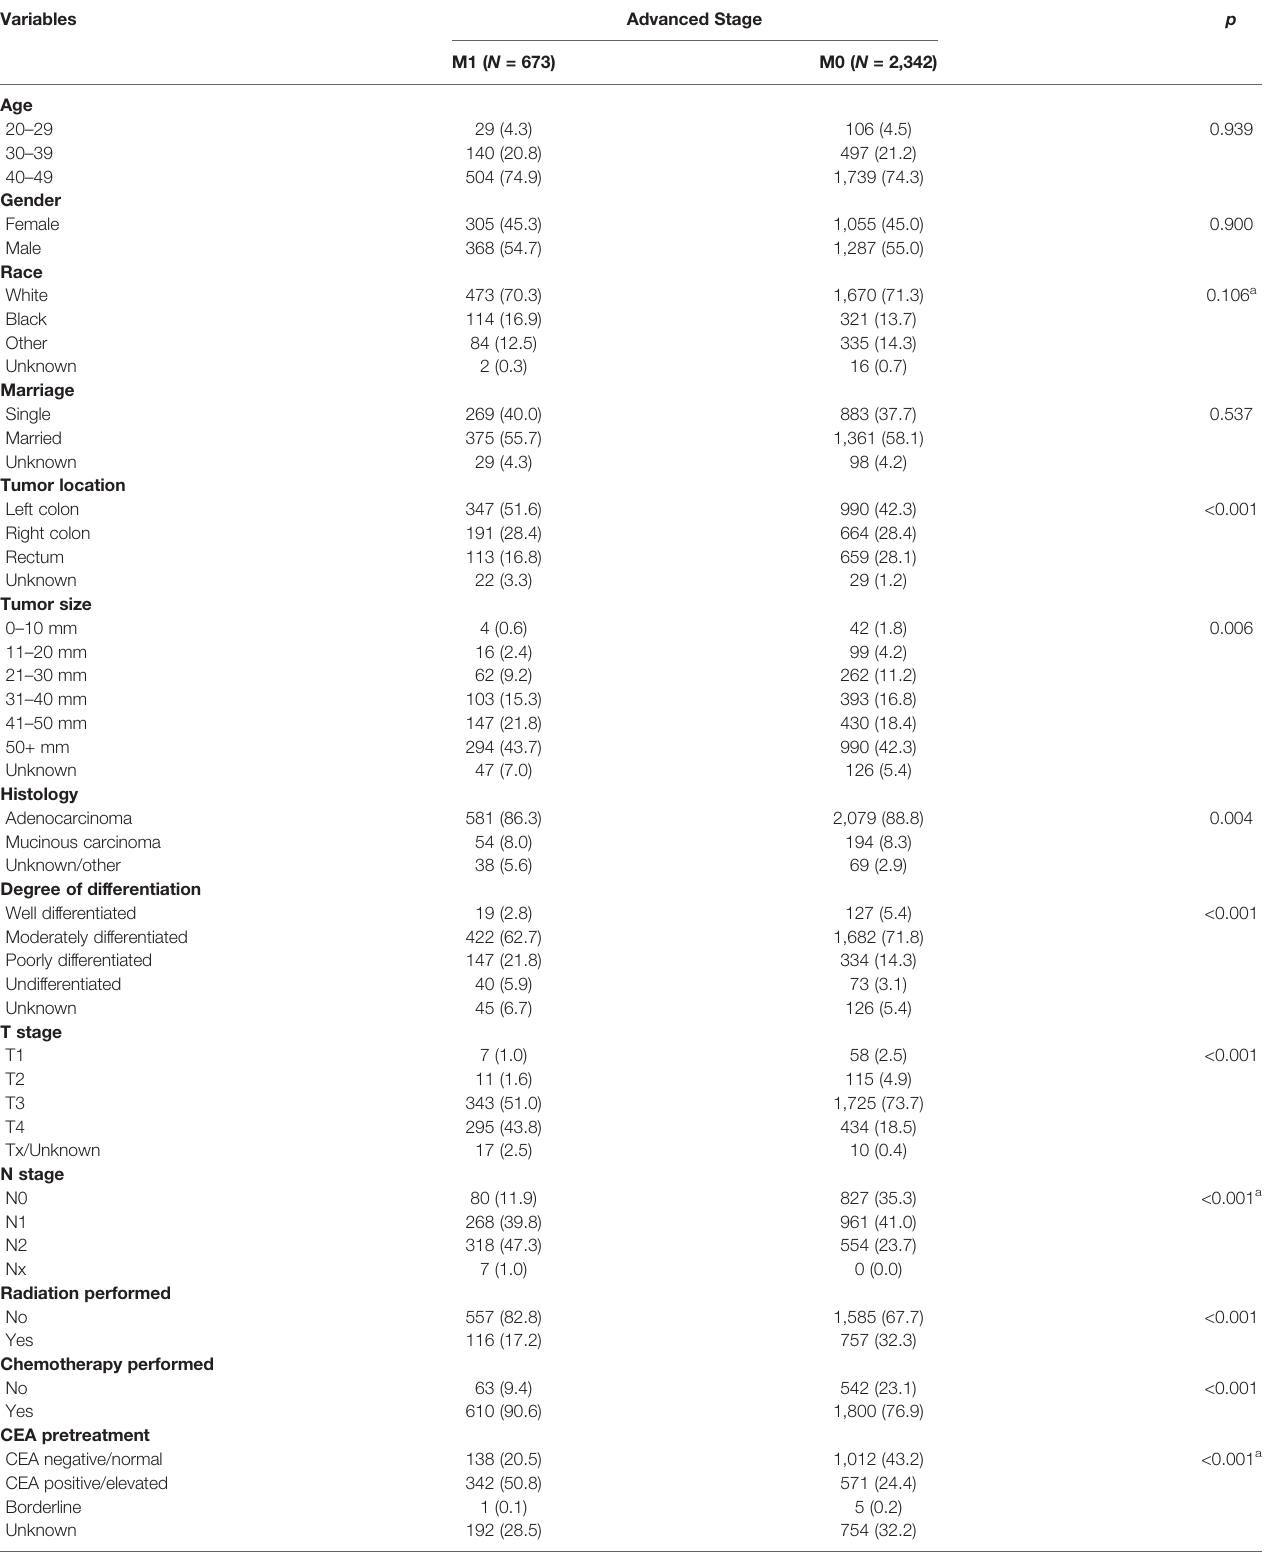
TABLE 5 | Risk factors associated with distant metastasis of young-onset colorectal cancer in advanced stage group of training